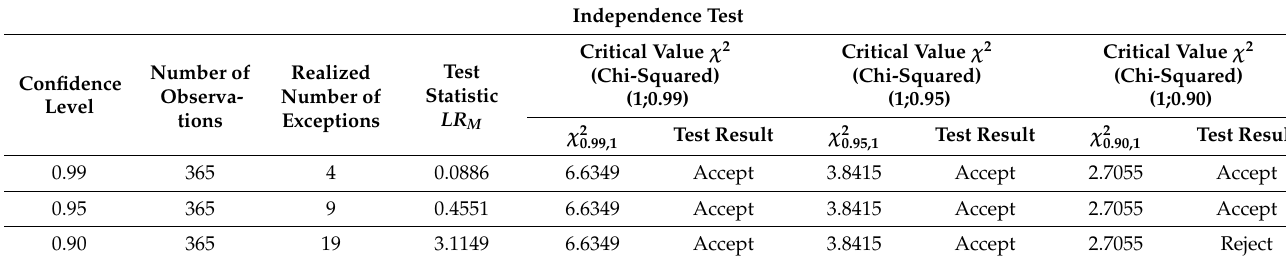
Table 8. Independence test on Delta-Normal VaR.